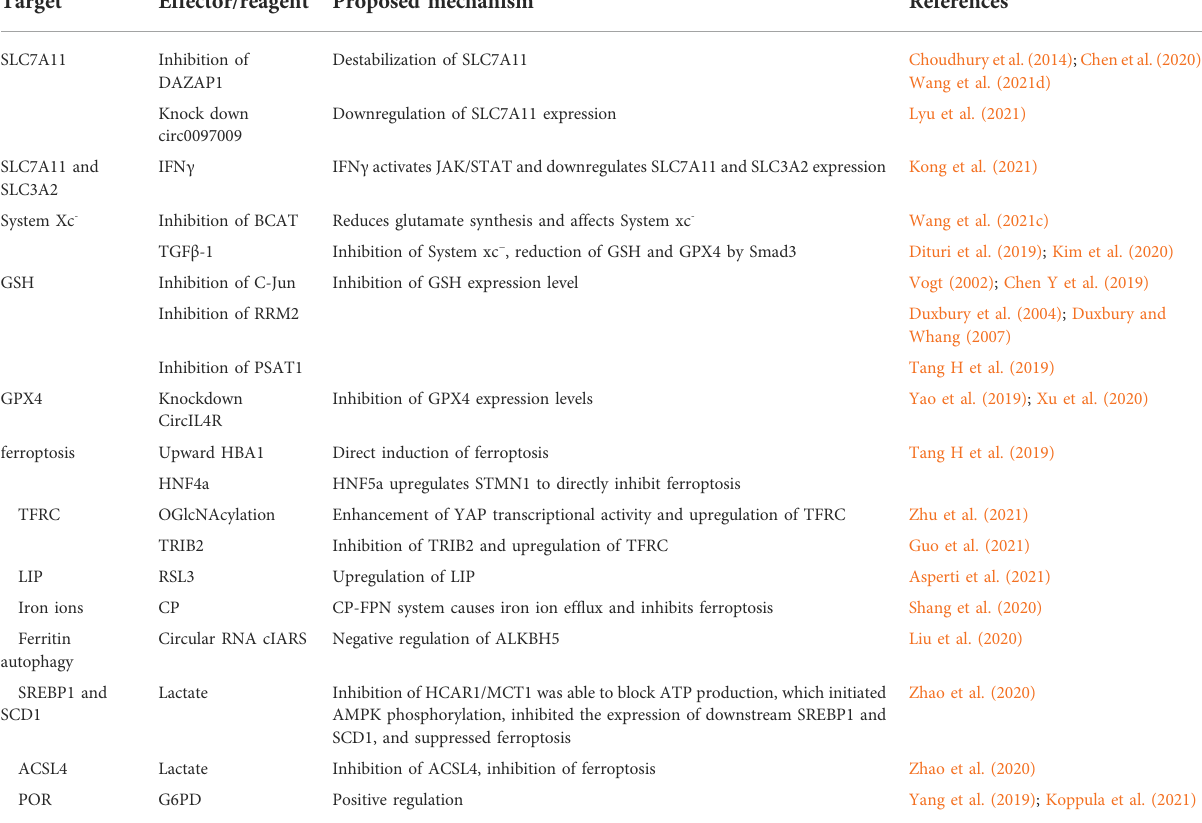
TABLE 1 Pathways and targets of ferroptosis in